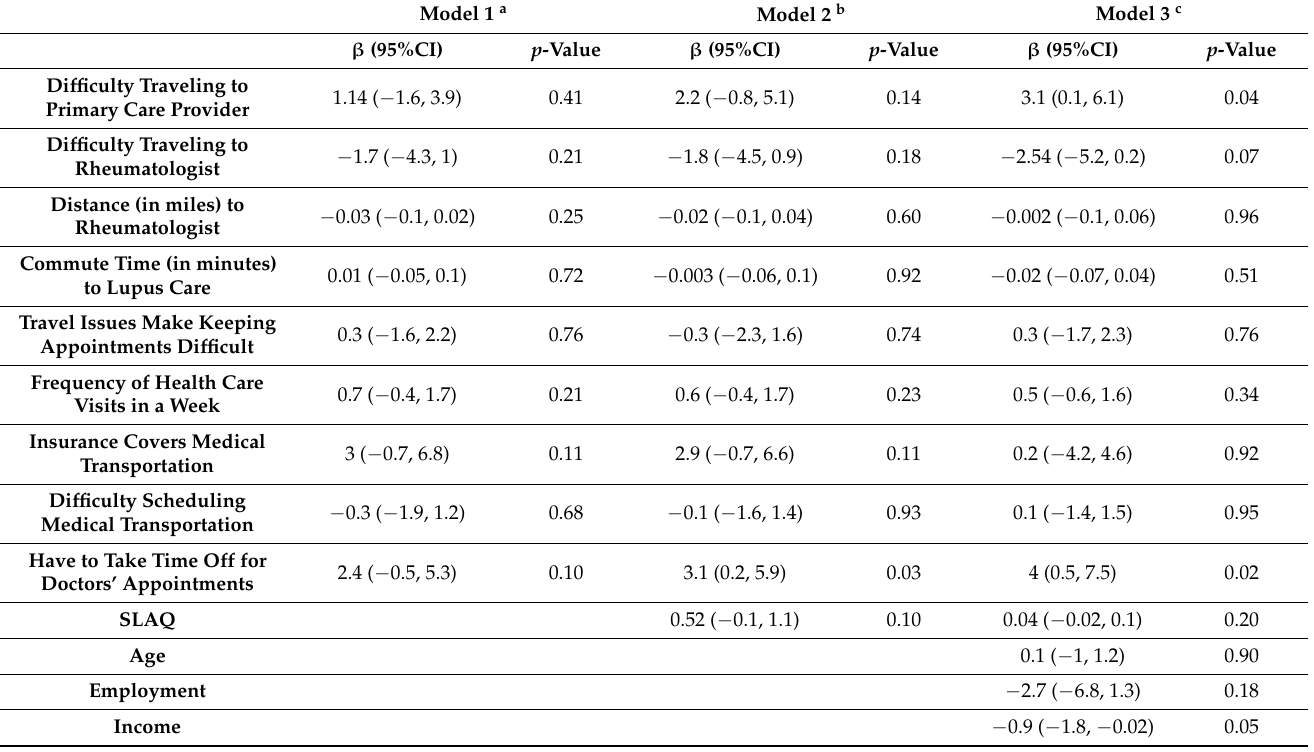
Table 4. Linear Regression Model of the Effect of Travel Burden Indicators on Anxiety